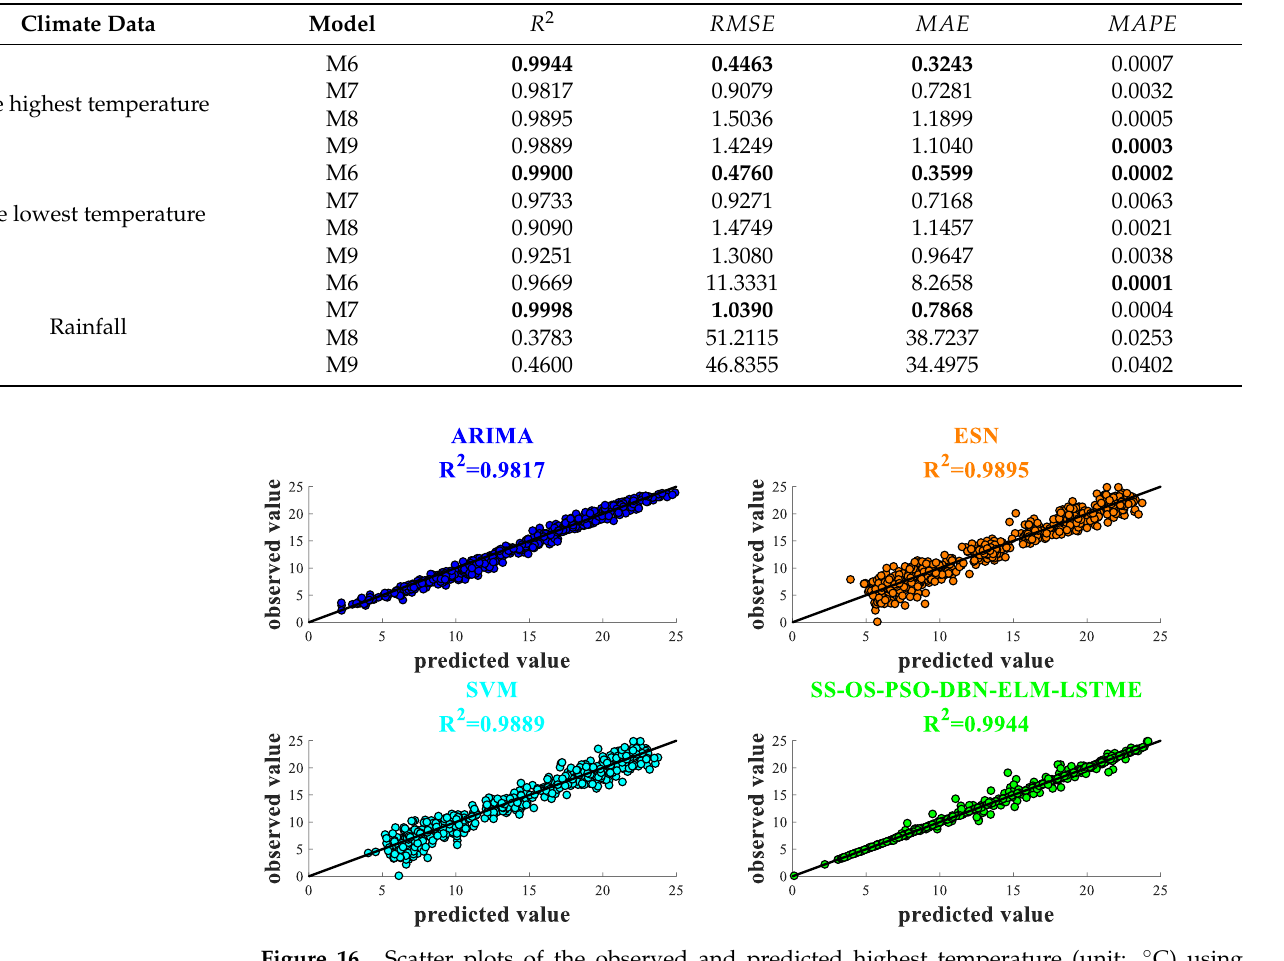
Figure 16. Scatter plots of the observed and predicted highest temperature (unit: °C) using M6–M9 models.